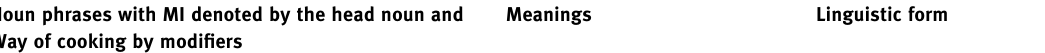
Table 3: NPs headed by a noun denoting the MI. Way of preparation is denoted by modi fi ers. Other modi fi ers may denote both MM and non - MM meanings Noun phrases with MI denoted by the head noun and Way of cooking by modi fi ers